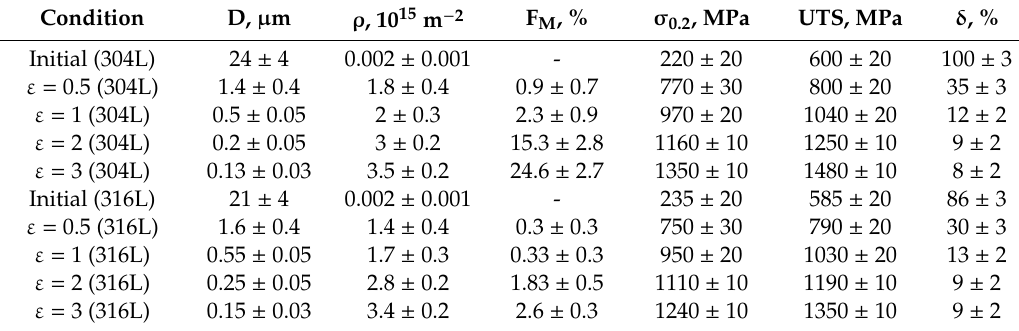
Figure 2. OIM images showing deformation microstructures evolved in a 316L stainless steel during rolling at 473 K to total strains of 0.5 ( a ), 1 ( b ), 2 ( c ) and 3 ( d ). High-angle, low-angle and twin boundaries are indicated by thick black, thin black and white lines, respectively. The inverse pole figures are shown for the normal direction (ND). Table 2. The grain size (D), the dislocation density ( ρ ), the martensite fraction (F M ), the yield strength ( σ 0.2 ), the ultimate tensile strength (UTS) and total elongation ( δ ) of 304L and 316L stainless steels subjected to rolling at 473 K to different strains ( ε ).